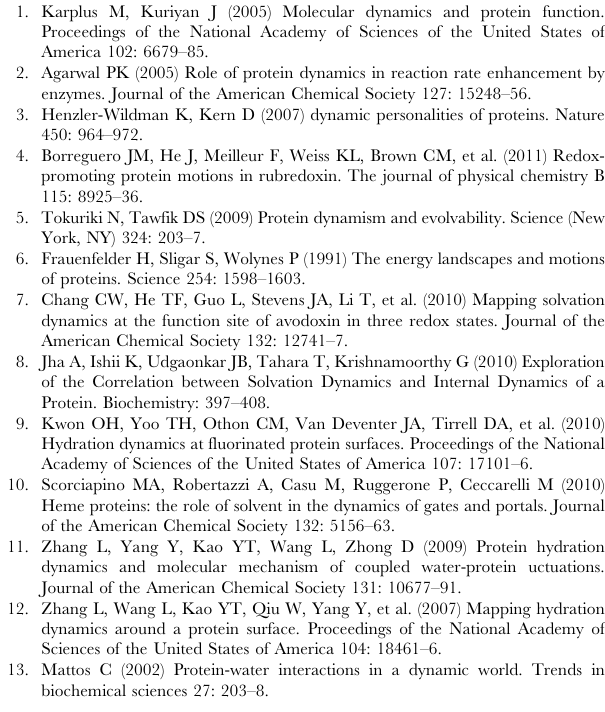
Figure S1 Distributions of energy standard deviations s E (square), s E (circle) and s E p p { w